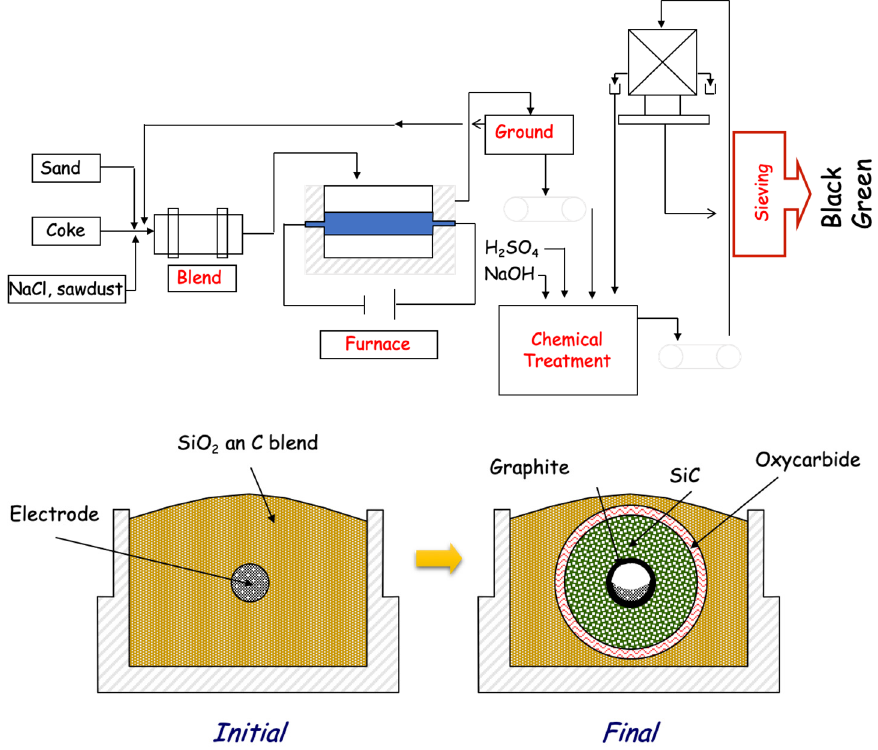
Figure 1. ( top ) Diagram of the Acheson process for obtaining SiC. ( bottom ) A detail of the furnace displaying the radial distribution of the products.